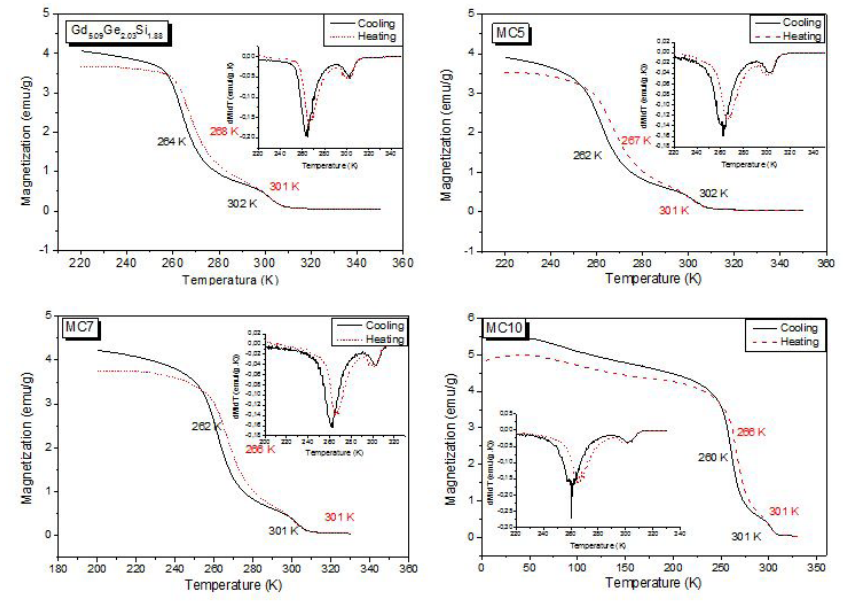
Figure 6. M vs. T measurements of Gd